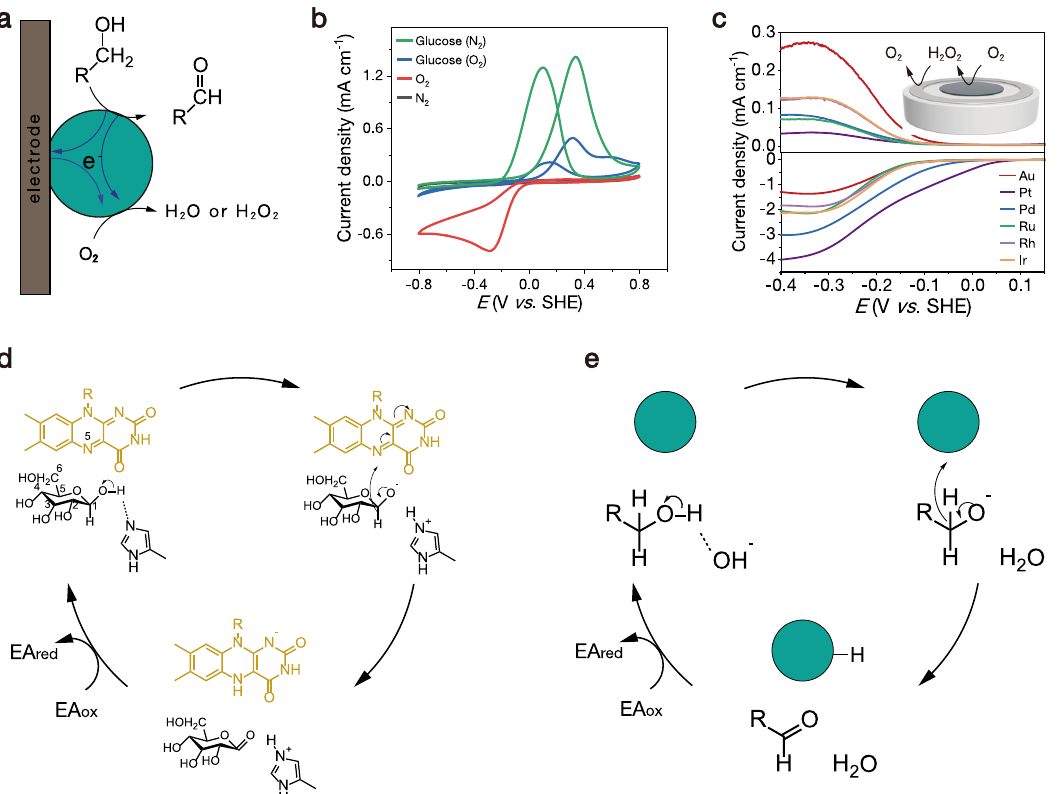
Fig. 2 Mechanism of glucose oxidation catalyzed by noble metal NPs. a Schematic illustration of electron transfer in the electrocatalytic oxidation of alcohols and the oxygen reduction reaction. b Cyclic voltammograms of Au NPs in N 2 - and O 2 - saturated 0.1 M NaOH solutions (with or without glucose). c RRDE measurements of the selective oxygen reduction of the catalysts in 0.1 M O 2 -saturated NaOH electrolyte. d Mechanism of glucose oxidation catalyzed by GOD. e Mechanism of glucose oxidation catalyzed by noble metal